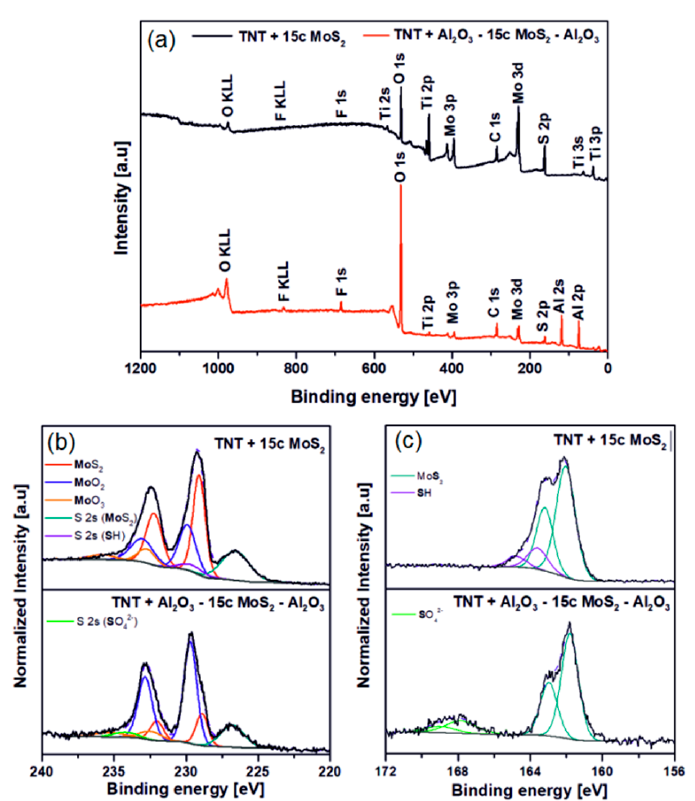
Figure 2. ( a ) X-ray photoelectron spectroscopy (XPS) survey spectra, ( b ) Mo 3d high resolution spectra and ( c ) S 2p high resolution spectra for TNT layers decorated with 15 cycles MoS 2 and with 9 cycles Al 2 O 3 —15 cycles MoS 2 —9 cycles Al 2 O 3 .